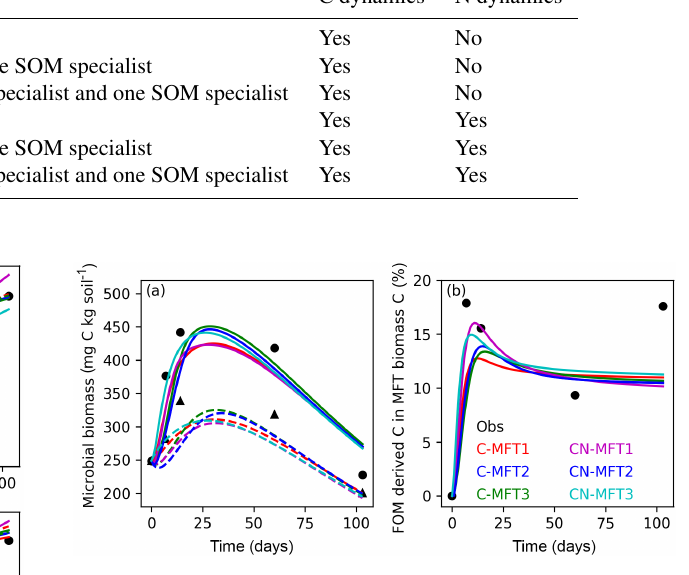
Figure 4. Modeled and observed microbial biomass and propor- tion of FOM derived C in the biomass of different MFTs (curve for C-MFT2 overlapped with CN-MFT2). Solid lines show the evolu- tion of microbial biomass or proportion of FOM derived C in MFT- biomass C with FOM addition; dashed lines show the evolution of microbial biomass without FOM addition. Black filled circles and triangles are the observation with and without FOM addition, re-